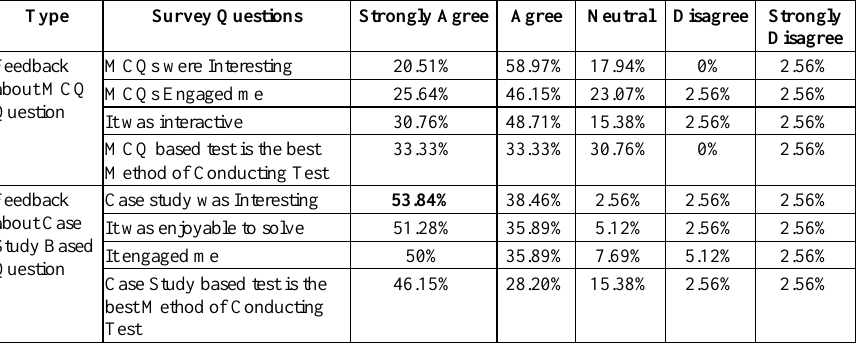
Table 3. : Summary of online feedback for Online